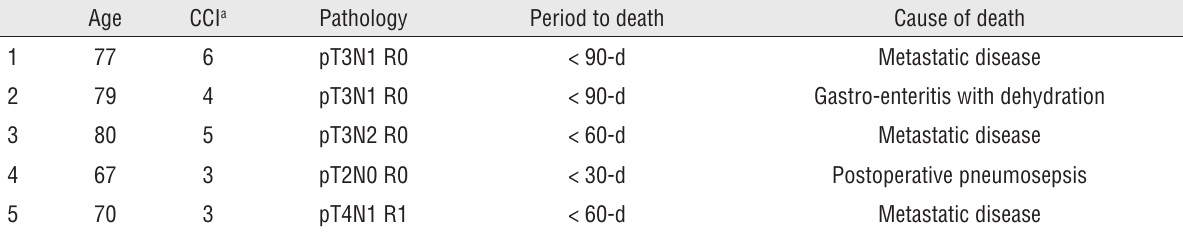
Table 5 - characteristics of patients who died within 90 days after